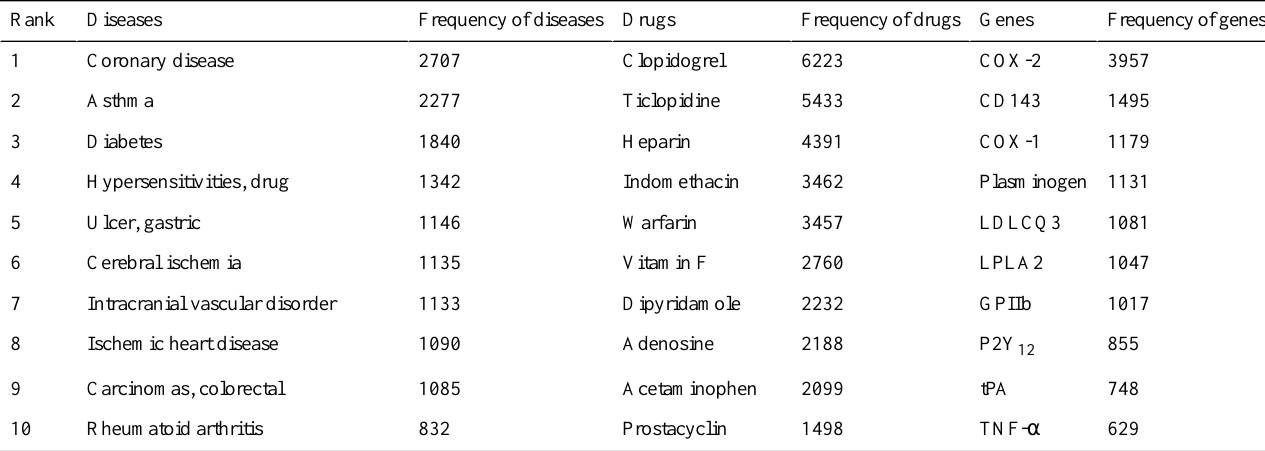
Table 2. Top 10 biomedical entities in aspirin-related publications during